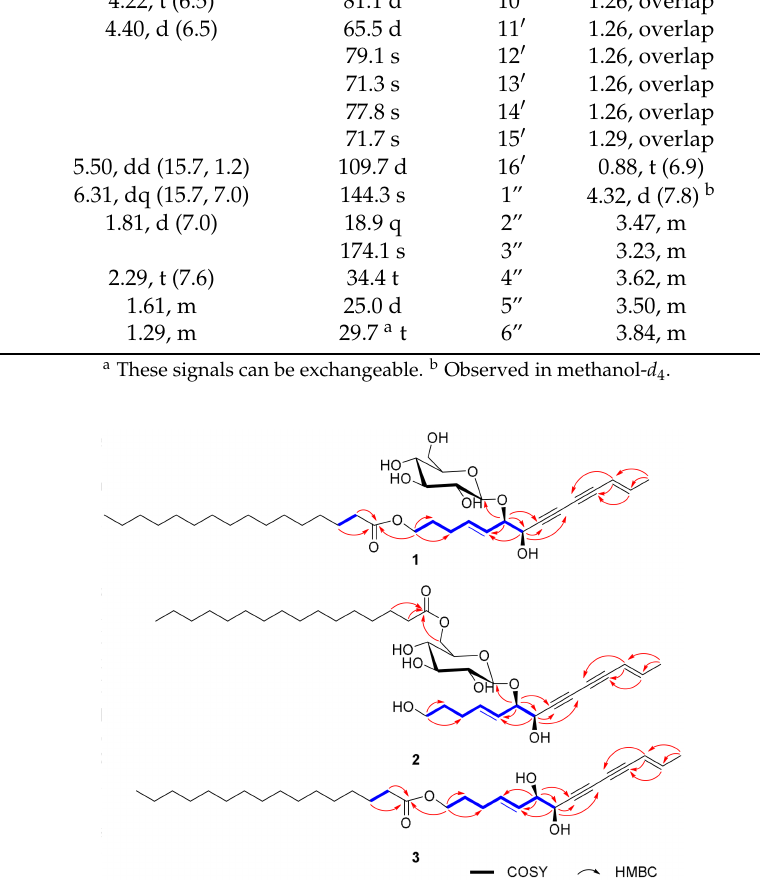
Figure 2. Key COSY and HMBC correlations for 1 – 3